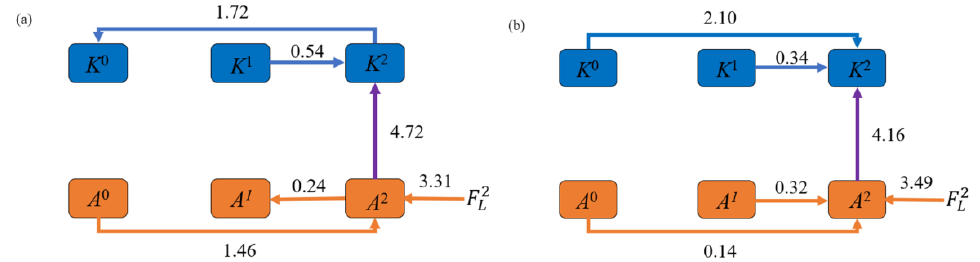
Figure 12. Schematics of the energy pathway for ( a ) Stage I and ( b ) Stage II. The energetics are in 10 − 4 m 2 s − 3 . An arrow stands for the energy flow 10 − 4 m 2 s − 3 . An arrow stands for the energy flow direction.